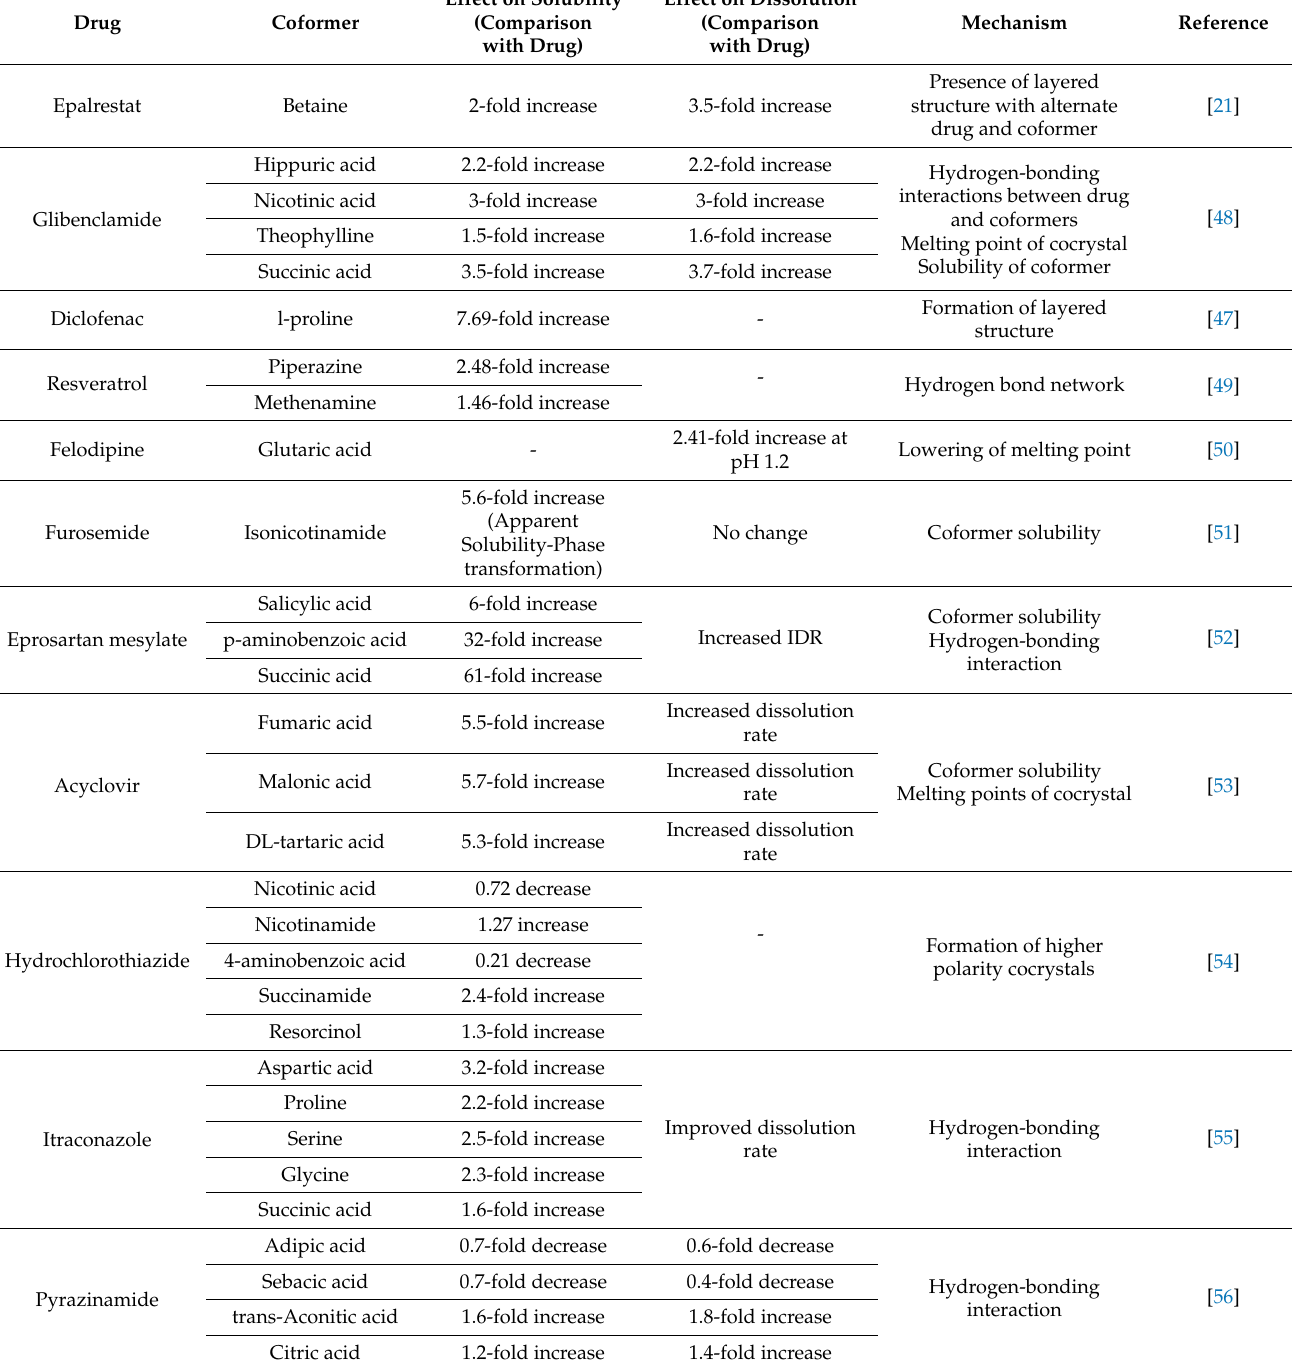
Table 1. Examples of studies reported on the effects of coformers on the solubility, dissolution rate, and bioavailability of drug molecules in